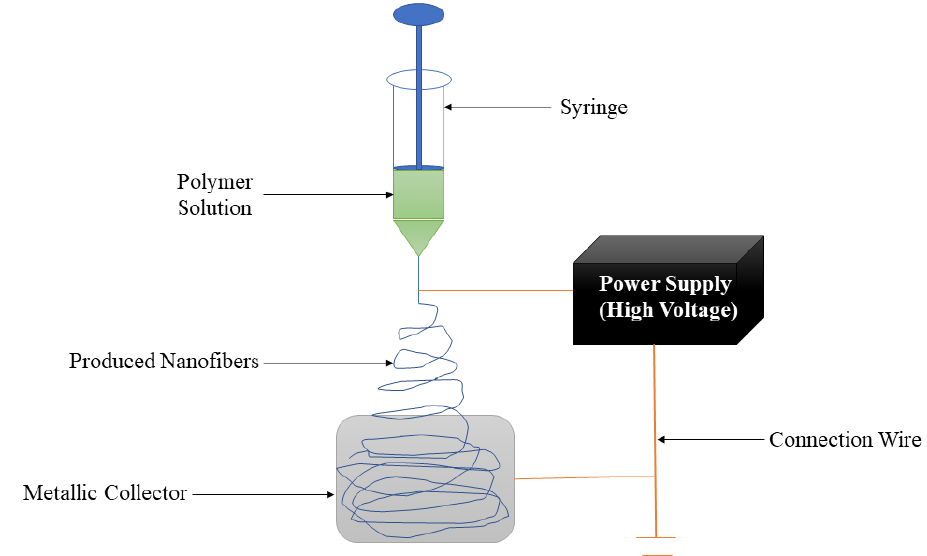
Figure 3. Fabrication of nanofibers via electrospinning technique.